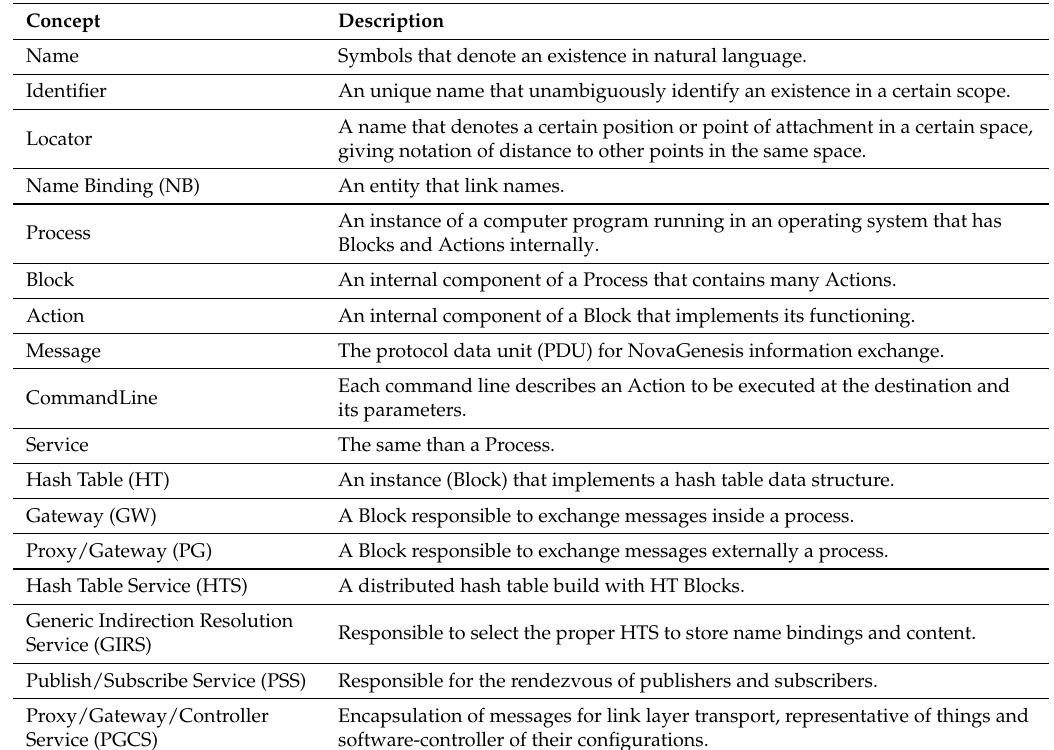
Table 3. NovaGenesis concepts